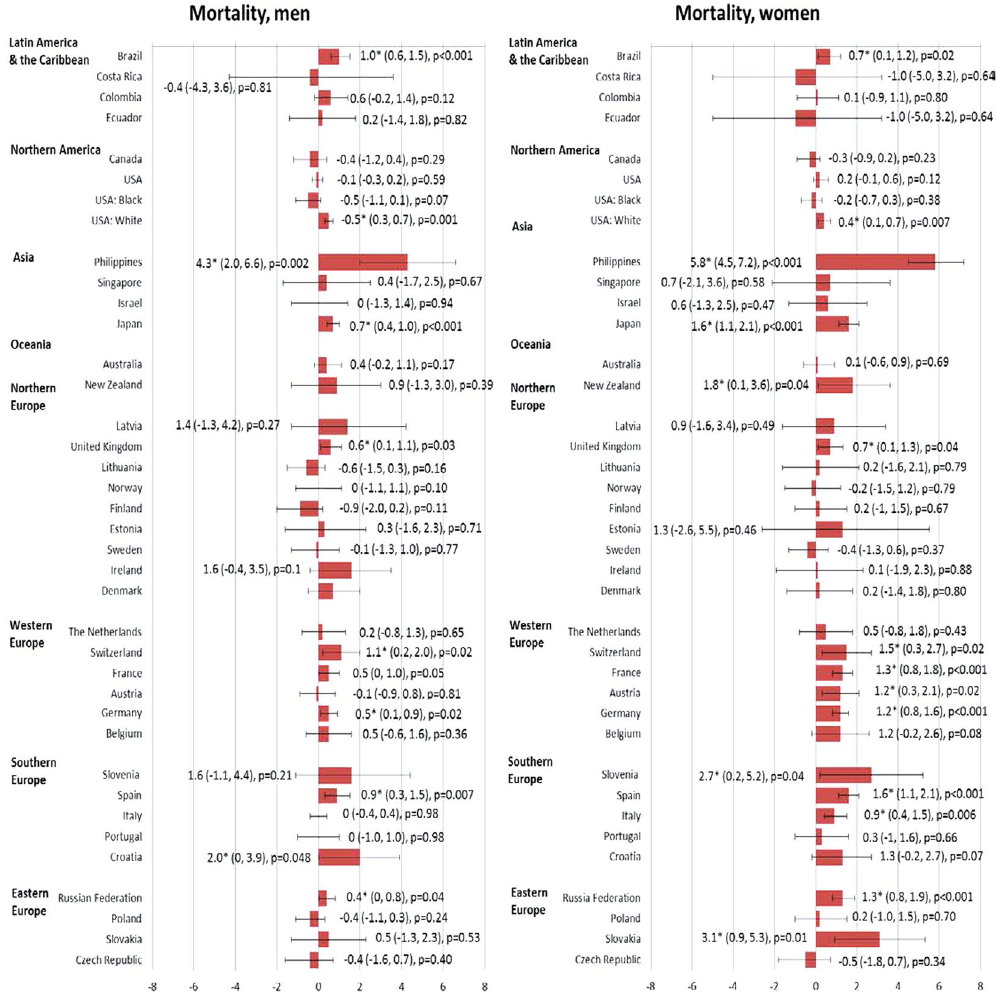
Figure 4. The Average Annual Percentage Change (AAPC) of pancreatic cancer mortality in men (left) and women (right)